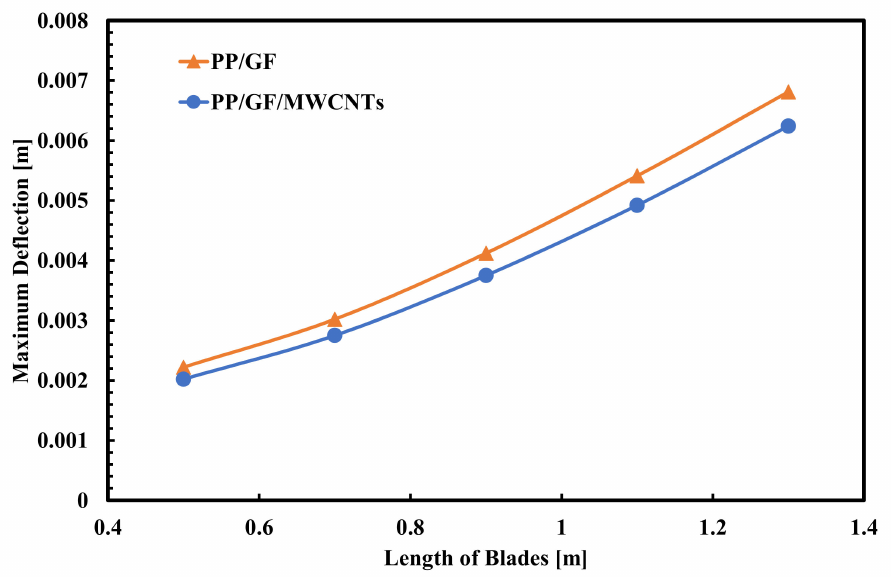
Figure 14. Maximum deflection of different blade